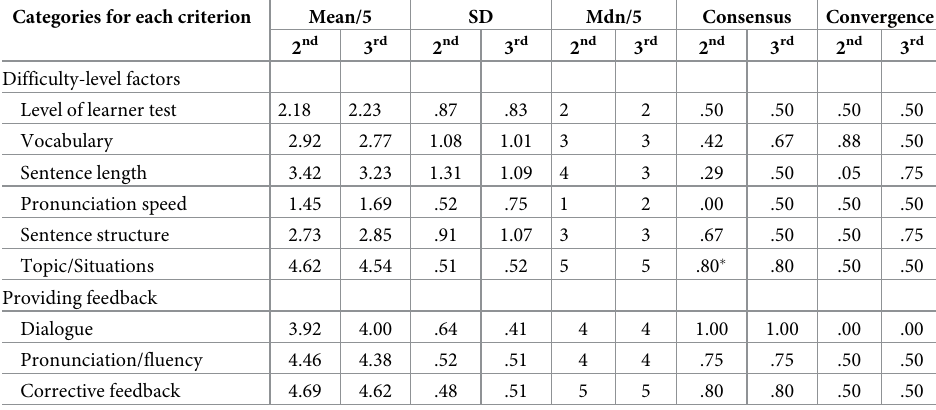
Table 7. Level of agreement with the appropriateness of the questions (second and third Delphi survey